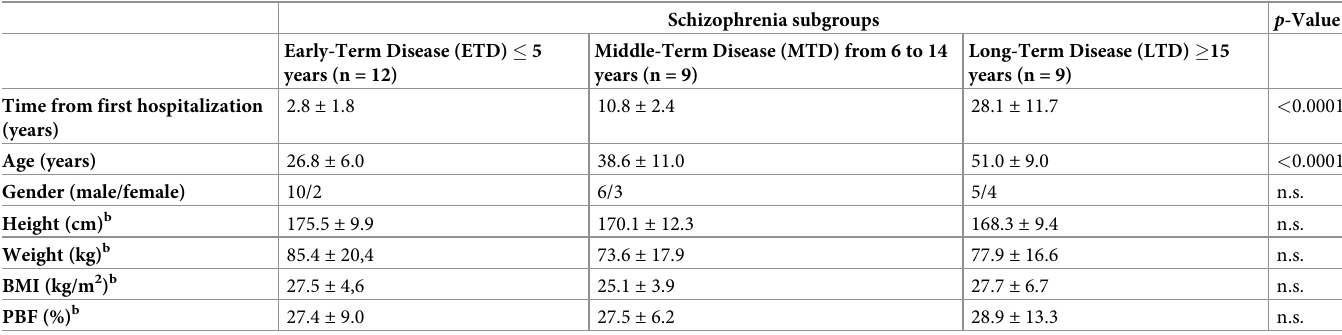
Table 2. Schizophrenia subgroups according to the time from first hospitalization.